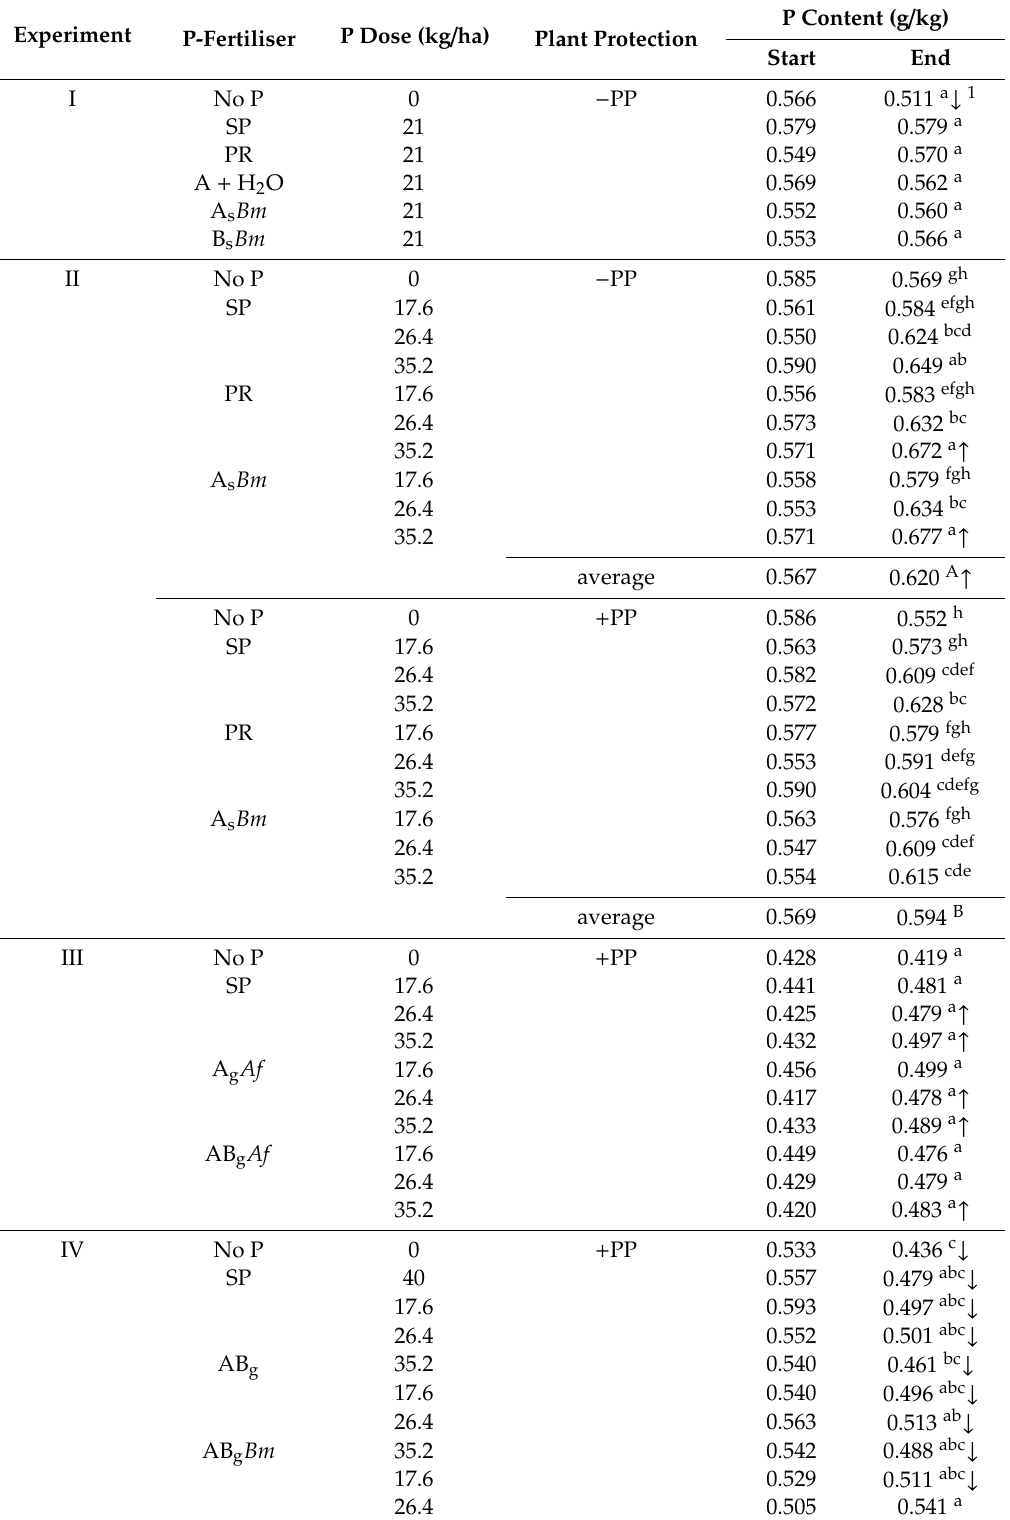
Table 6. Total P content in soil from wheat